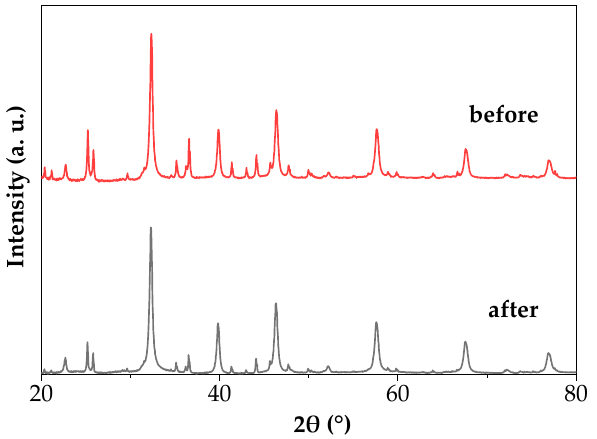
Figure 9. Powder X-ray diffraction pattern of the best performing catalyst before and after the photocatalytic tests (after three cycles)